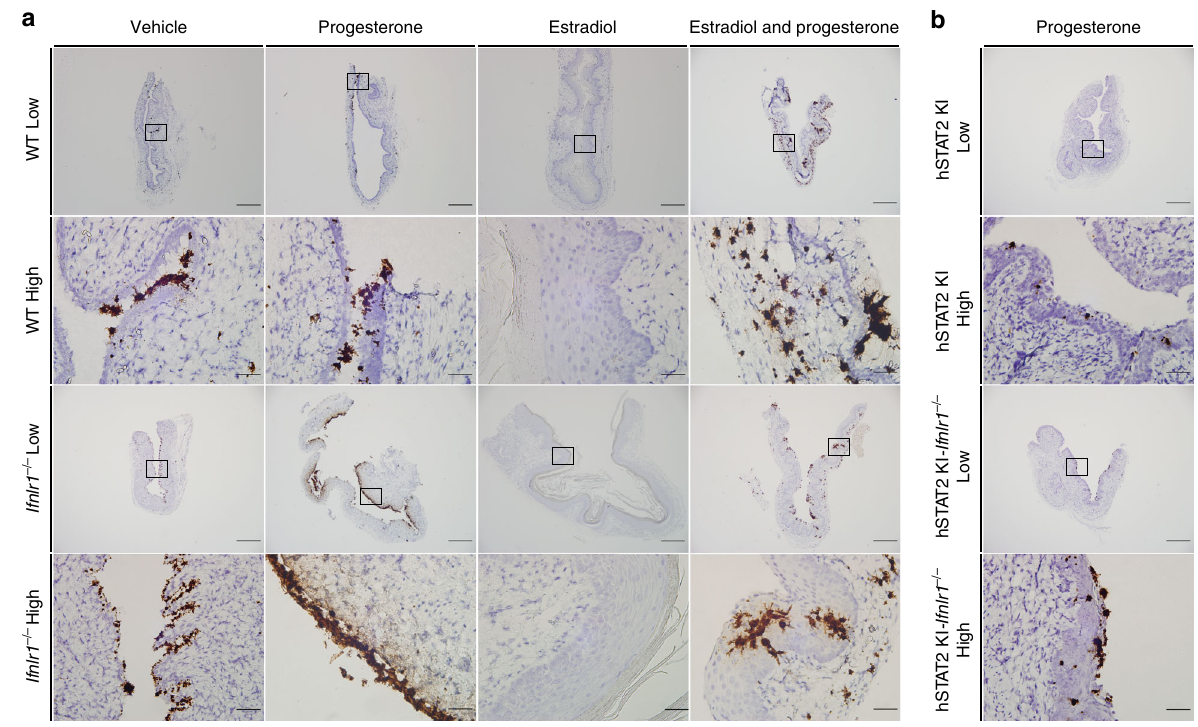
Fig. 4 Increased ZIKV infection in the vagina of progesterone-treated OVX Ifnlr1 − / − and hSTAT2 KI Ifnlr1 − / − mice. Six week-old WT, Ifnlr1 − / − , hSTAT2 KI, or hSTAT2 KI Ifnlr1 − / − OVX mice were given a hormone replacement regimen of estradiol, progesterone, estradiol and progesterone, or vehicle. WT and Ifnlr1 − / − mice were treated with 1 mg of anti-Ifnar1 mAb at day − 1. On day 0, mice were inoculated via intravaginal route with 10 6 FFU of ZIKV (Dakar 41525). At 7 dpi, ZIKV RNA was stained using ISH on vaginal tissue (WT and Ifnlr1 − / − , a ; hSTAT2KI and hSTAT2 KI Ifnlr1 − / − , b ). Images are representative of two or three experiments. Low magni fi cation scale bar = 500 μ m, high magni fi cation scale bar = 50 μ m. Numbers of mice analyzed: Vehicle: WT + anti-Ifnar1, n = 10; Ifnlr1 − / − + anti-Ifnar1, n = 7. Progesterone: WT + anti-Ifnar1, n = 16; Ifnlr1 − / − + anti-Ifnar1, n = 11; hSTAT2 KI, n = 7; or hSTAT2 KI Ifnlr1 − / − , n = 5. Estradiol: WT + anti-Ifnar1, n = 10; Ifnlr1 − / − + anti-Ifnar1, n = 6. Estradiol and progesterone: WT + anti-Ifnar1, n = 9; Ifnlr1 − /